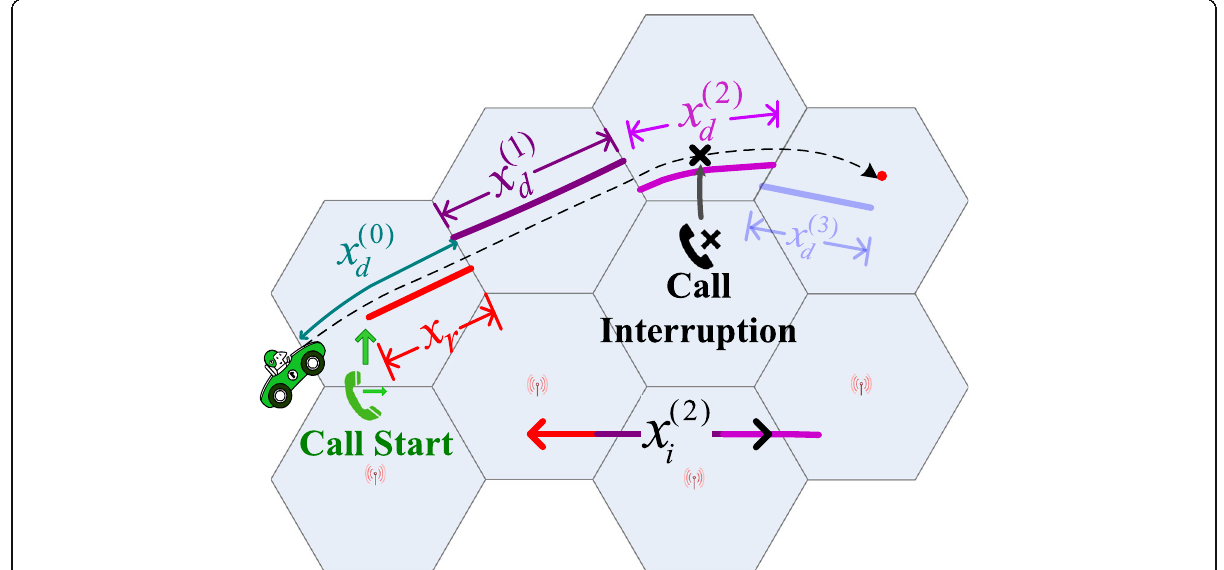
Fig. 3 Relationship between the cell residence and interruption times for interrupted